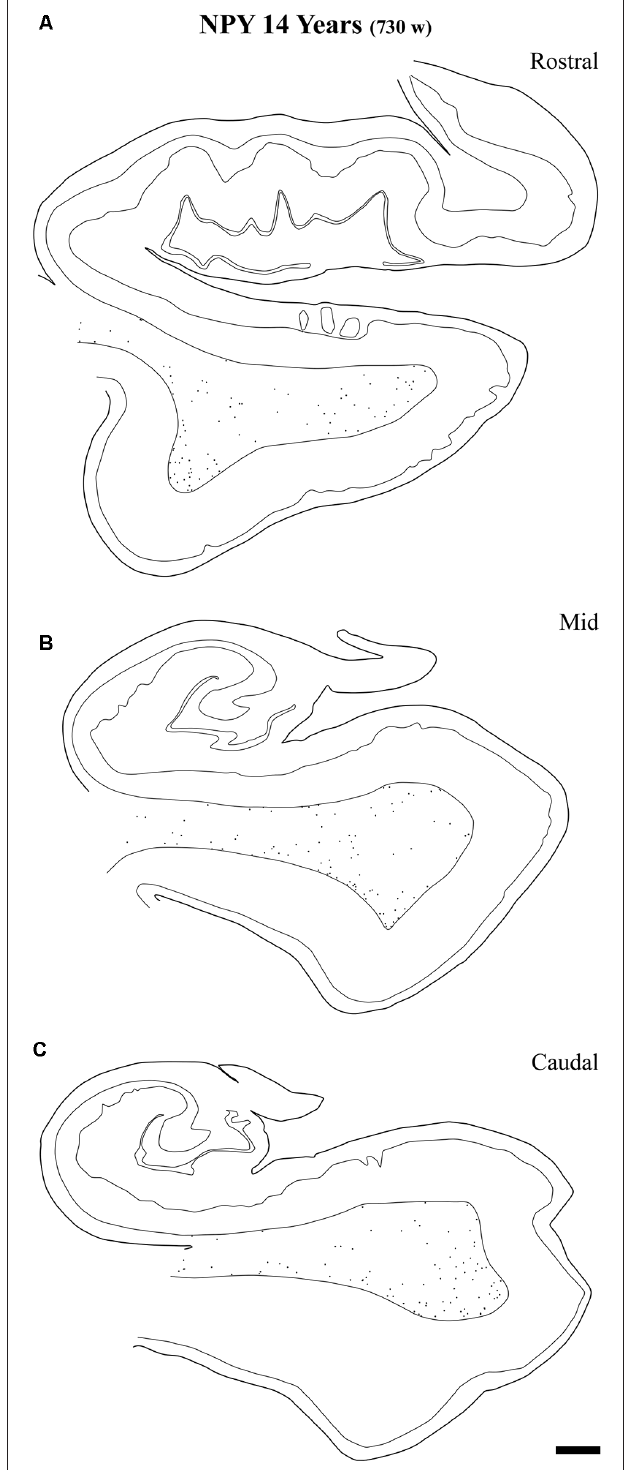
FIGURE 12 | Representation of the NPY-positive labeling in a 14-year-old case at the level of the head (A) body (B) and tail (C) of the angular bundle. The decrease in density at the three topographical levels of the angular bundle is noticeable, in particular compared to ages younger than 23 months. Other conventions as in Figure 3 . Scale bar is 2